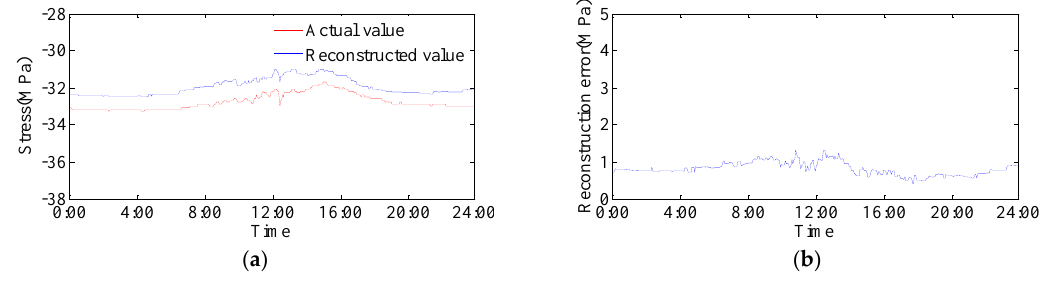
Figure 10. The reconstructed value and actual value using response variables X P 6 : ( a ) the curve of the reconstructed value and the actual value; and ( b ) the curve of reconstruction error.